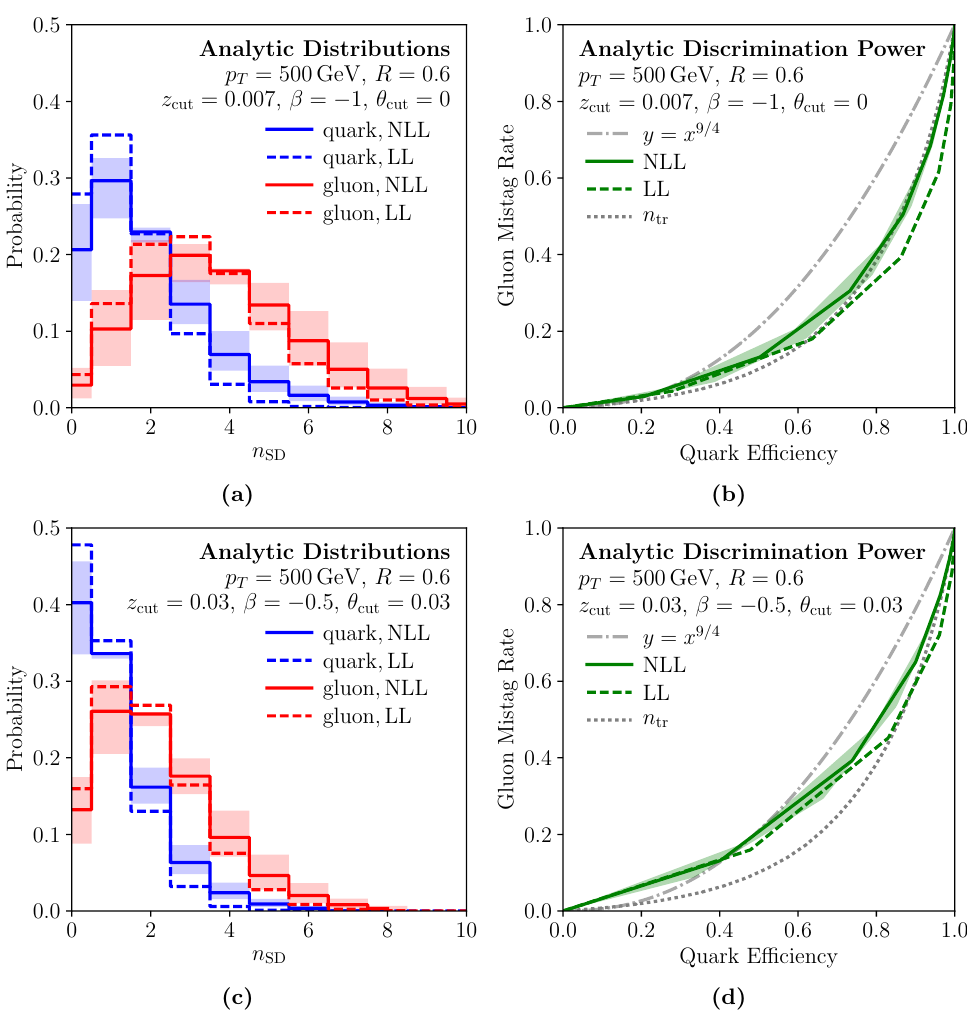
Figure 11. Calculations at LL and NLL accuracy for (left column) n (right column) the corresponding quark/gluon ROC curves. Parameters are chosen according to eqs. (3.17), (3.18) and (3.20) with (cid:3) NP = 2 GeV and (top row) (cid:12) =